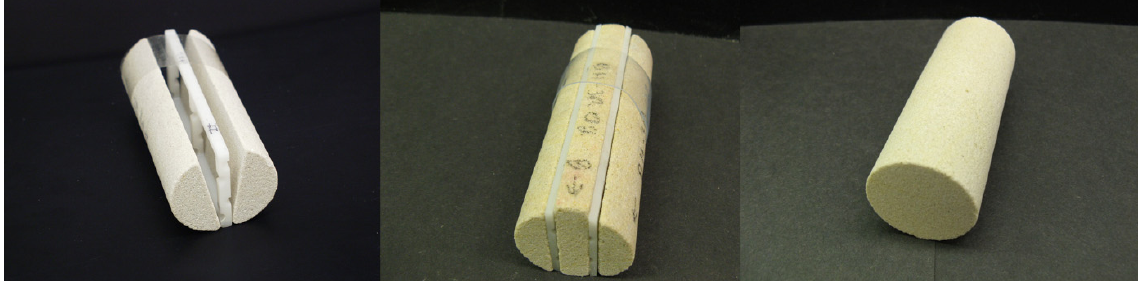
Figure 4. Three different core configurations were applied in this study. The fractured